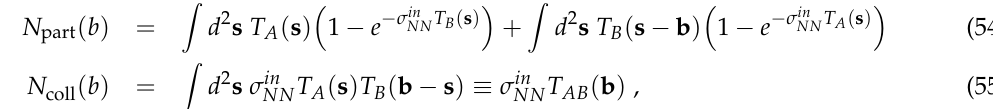
(cid:113) σ in / π . NN